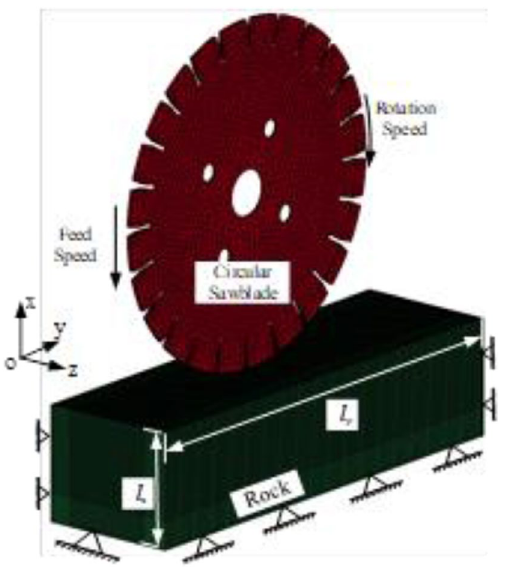
Figure 2. The circular saw blade cutting rock numerical simulation model.